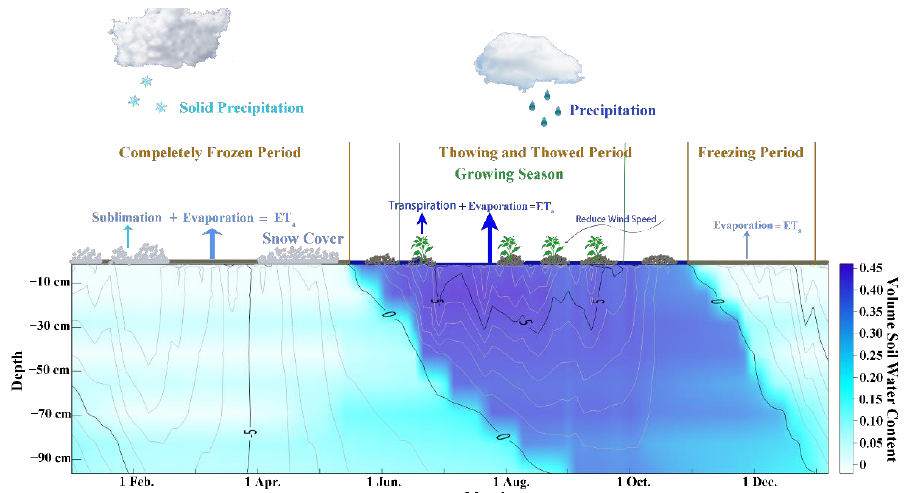
Figure 10. The process of evapotranspiration at the alpine swamp meadow; the bottom half refers to the VSWC and ST; ST and VSWC are denoted by contours and color strips, respectively. The upper half shows the condition of the underlying surface. The arrow implies evapotranspiration from the surface and the dark blue underlying surface represents the exposed water.